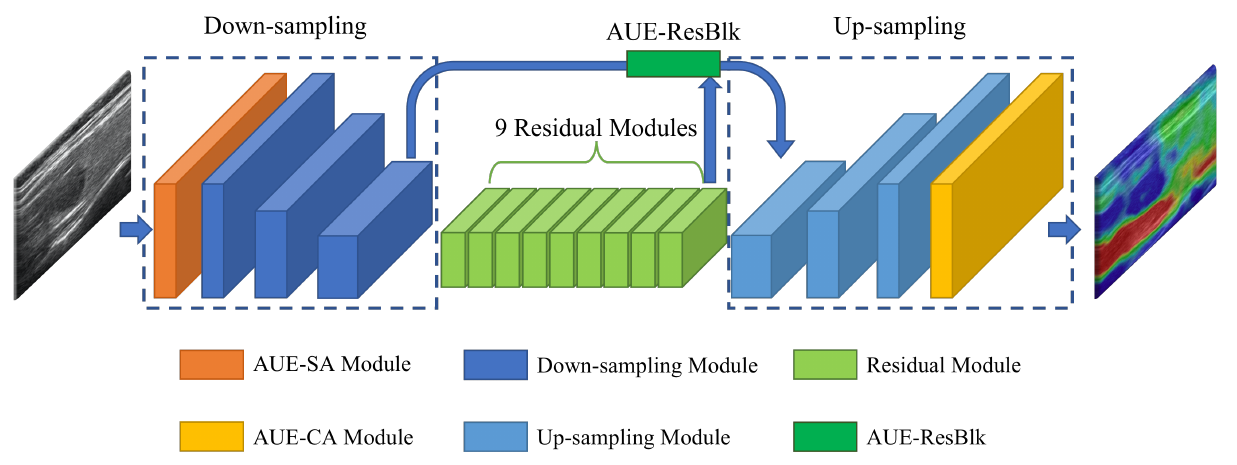
Figure 3. Architecture of AUE-net, which consists of 1 AUE-SA module, three down-sampling mod- ules, nine residual blocks, three up-sampling modules, one AUE-CA module, and one AUE-ResBlk. First, we cropped the raw image at fixed locations (left, right, upper, and lower boundaries) in the image according to different ultrasound